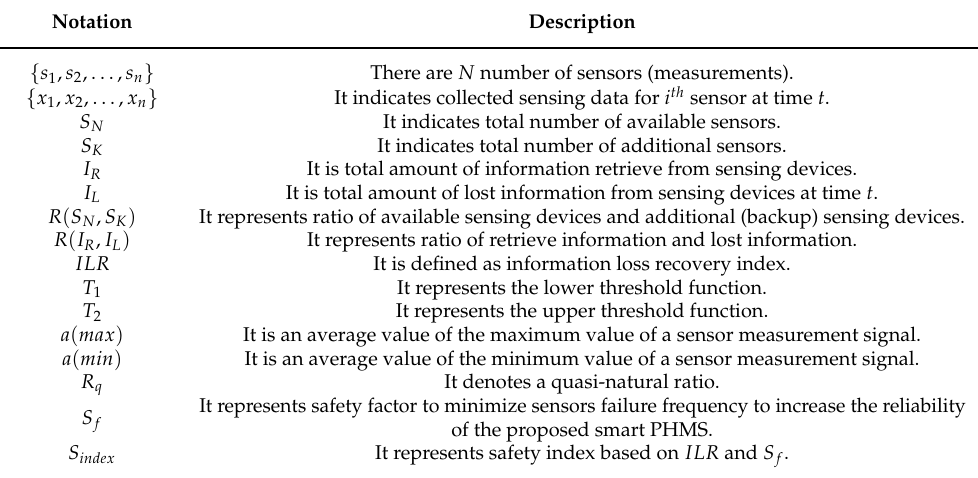
Table 2. Description of notations and symbols used in the